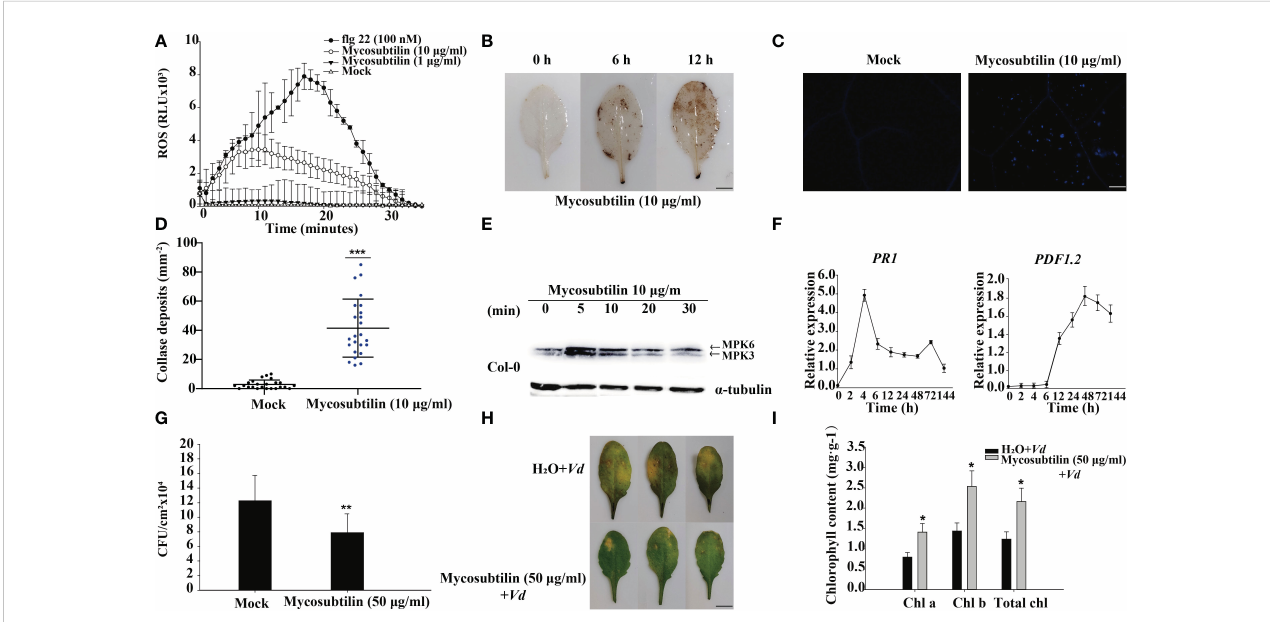
FIGURE 1 The early immune response of plants to mycosubtilin homologues. (A, B) Effects on the burst of reactive oxygen species in Arabidopsis leaves, means ± SD, n = 24, repeat = 3, scale bars 0.5 cm. (C, D) Effect on callose deposition in Arabidopsis leaves, n = 24, repeat = 3, scale bars 200 m m. (E) Mycosubtilin homologues activate MAPK signaling pathway in Arabidopsis ; a -tubulin was used as an equal loading control. (F) Inducible expression of Arabidopsis resistance-associated genes PR1 and PDF1.2 , Means ± SD, n = 12, repeat = 3. (G, H, I) Mycosubtilin homologues protects to Arabidopsis against pathogenic bacteria, means ± SD, n = 24, repeat = 3, Scale bars 0.5 cm. *, ** and *** indicate statistical signi fi cance at p < 0.05, p < 0.01 and p < 0.001, respectively (Student ’ s